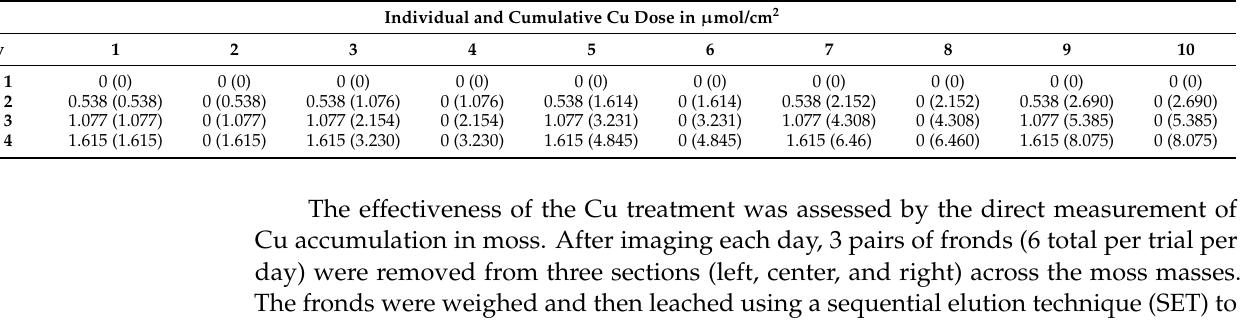
Table 1. Experimental doses of metal added each day ( µ mol Cu per cm 2 ), with cumulative concentra- tions of Cu reached by that day of the experiment provided in parentheses. Individual and Cumulative Cu Dose in µ mol/cm